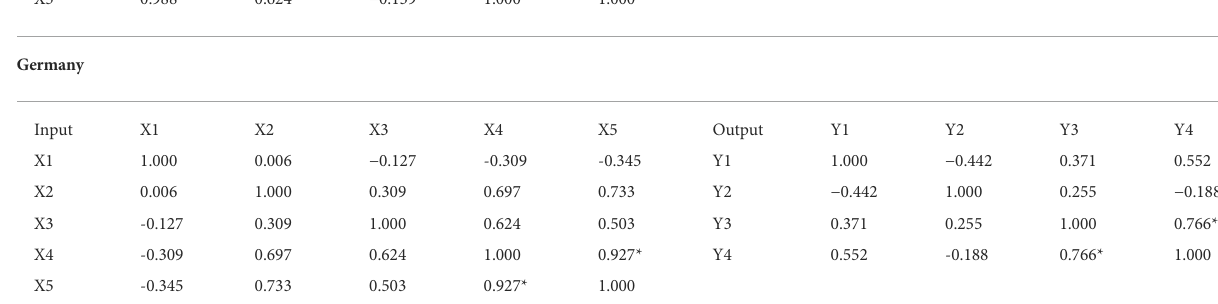
* indicates a strong correlation between the two indicators.